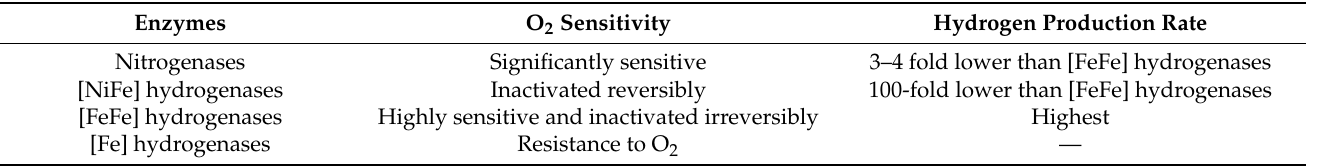
Table 2. Comparison of enzyme O 2 sensitivity and hydrogen production rate